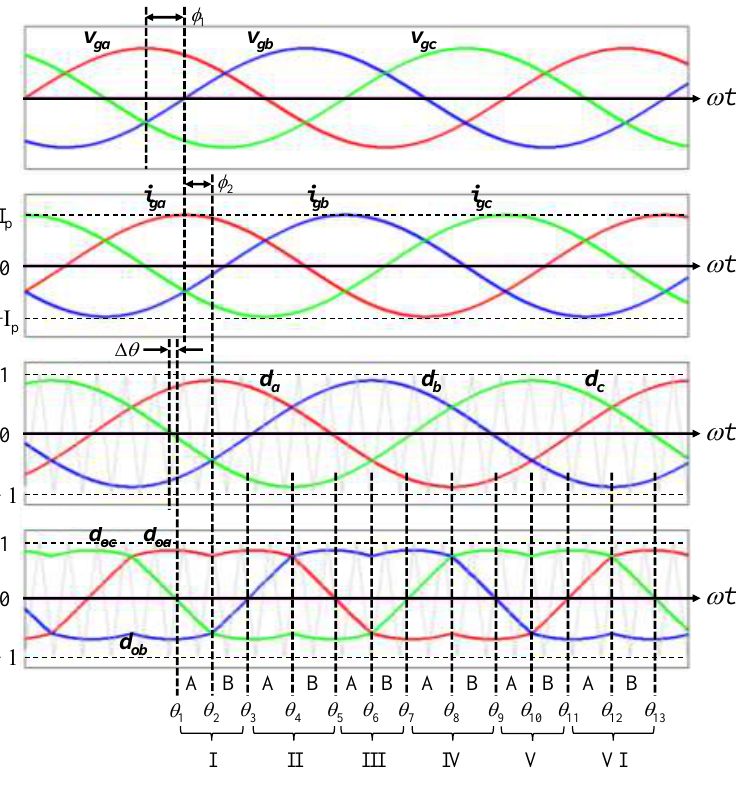
Figure 3. Theoretical steady state operational waveforms. The three-phase duties are converted to the final duties ( d oa , d ob , and d oc ) as shown in the lowest waveform of Figure 3 through the space vector PWM technique [10] and the addition of offset voltage for neutral point current control.